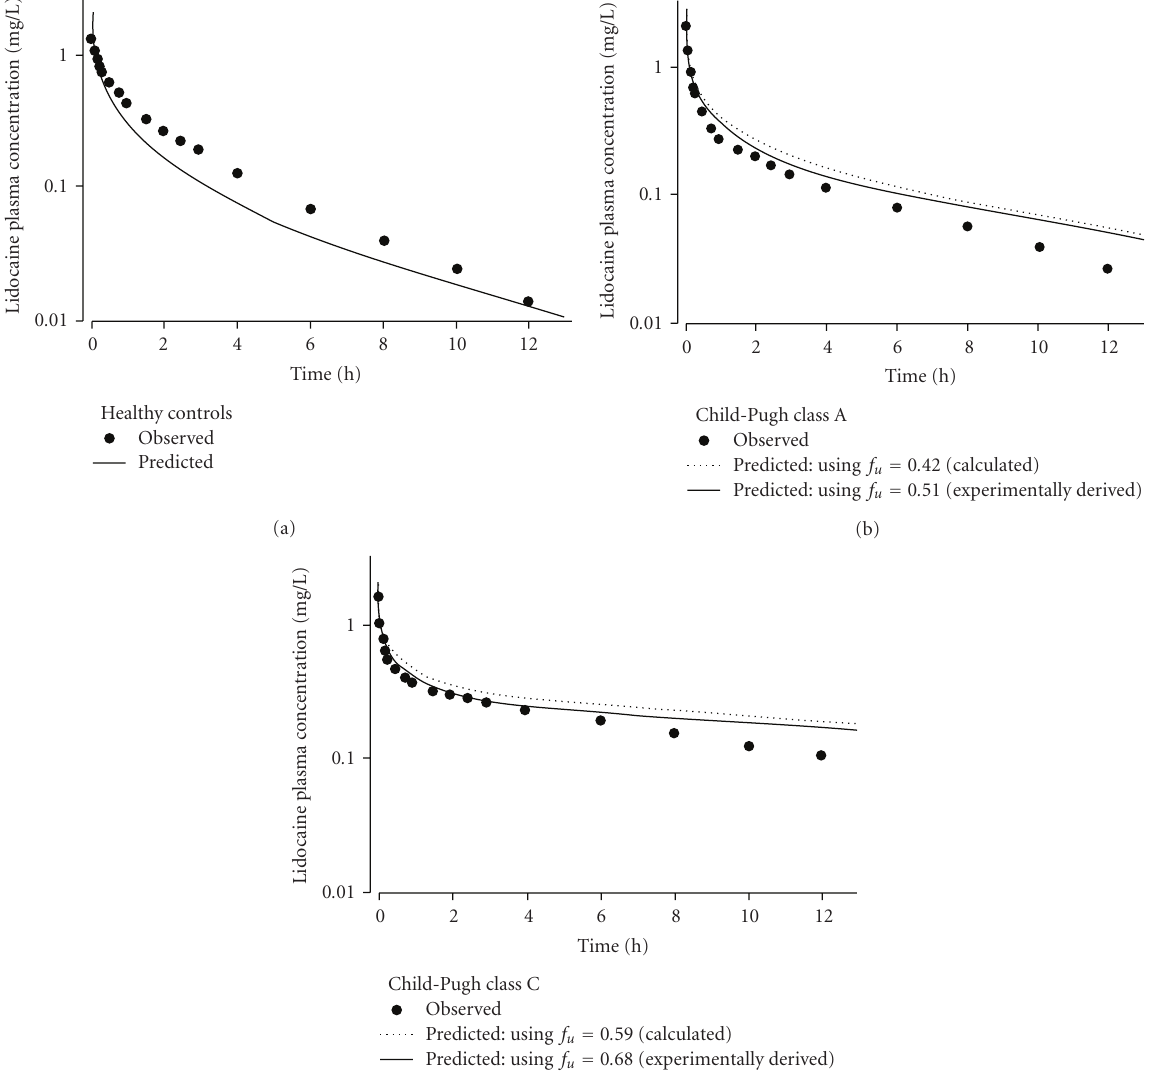
drugs was simulated in adults and compared with the